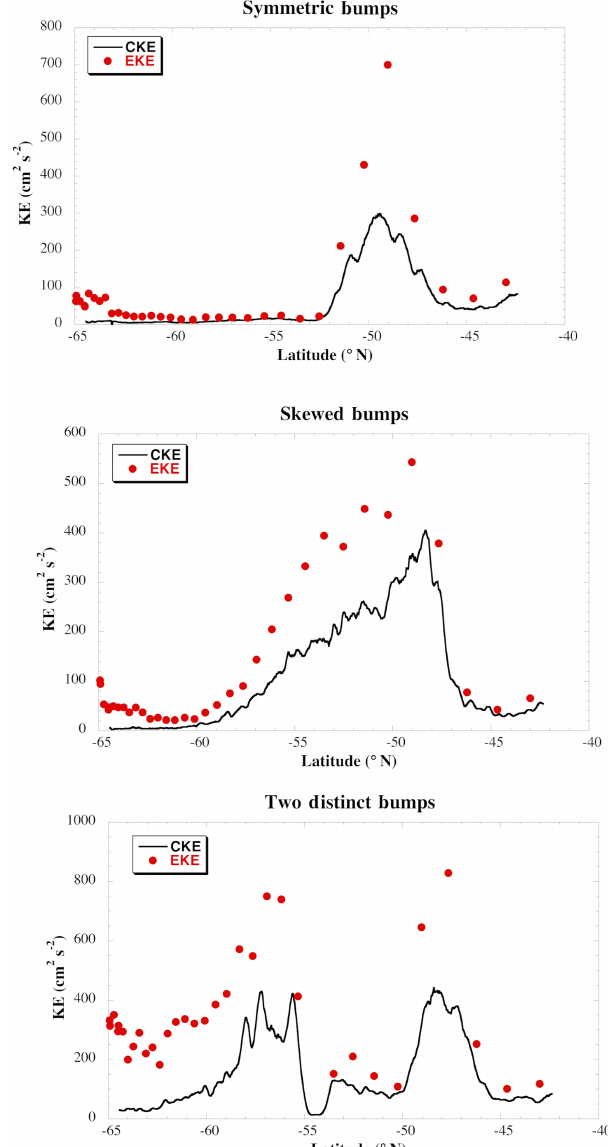
Figure 5. Examples of the three types of CKE profiles found (black lines), along with the value of the full EKE computed at crossover